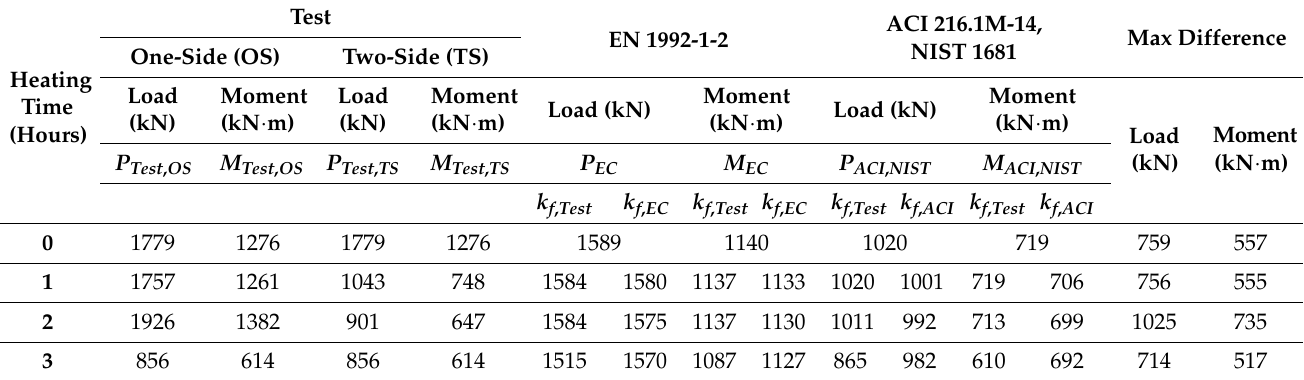
Table 13. Load and moment according to the strength reduction factor for each standard (EN 1992-1-2 [17], ACI 216.1M-14 [18], and NIST 1681 [19]).